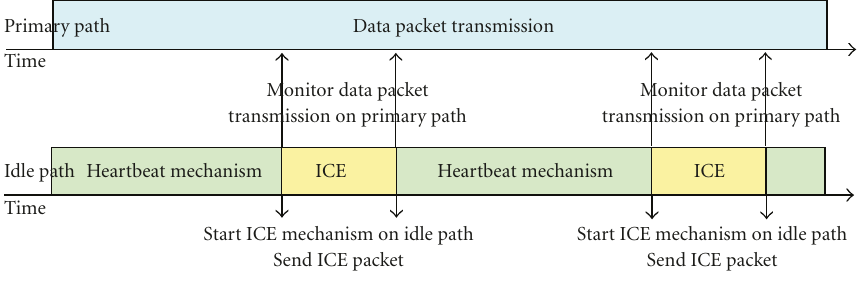
Figure 5: ICE mechanism: ICE operation